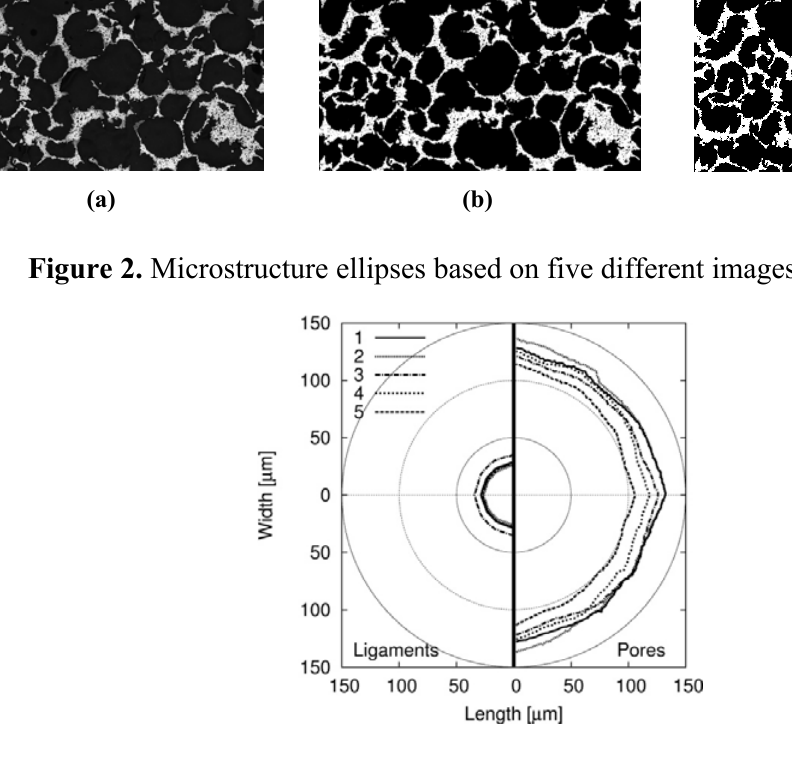
Figure 3 . Analyzed porous materials with properties shown in Table 1.